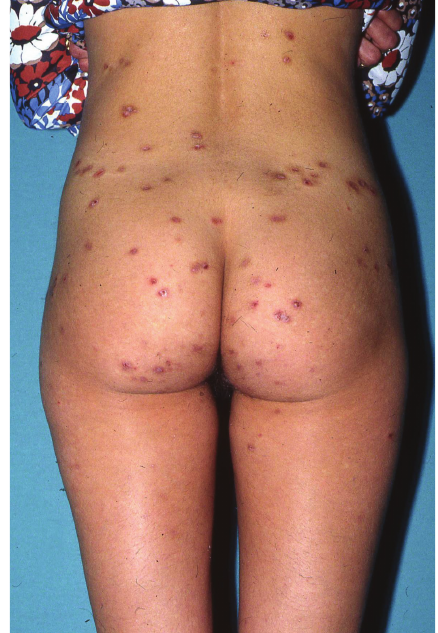
Figure 4: Excoriations, scratch marks, and prurigo nodules in ICP.